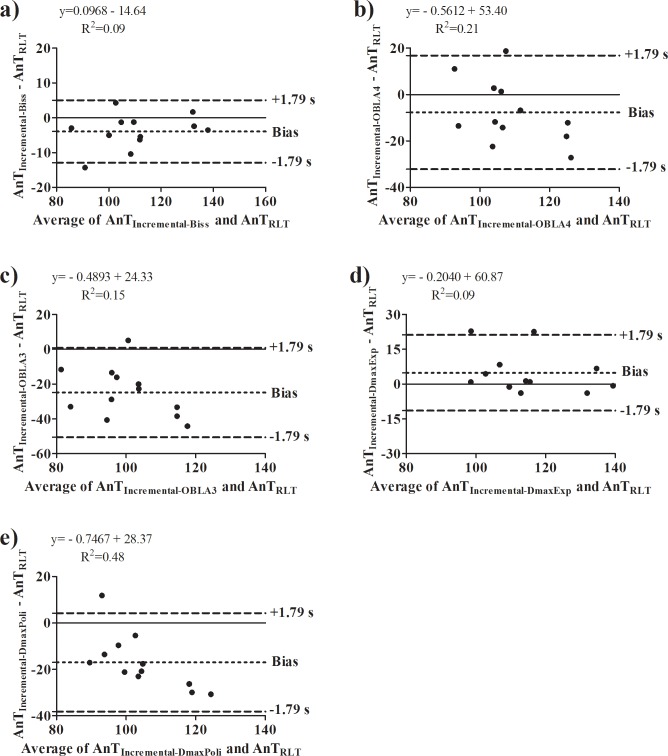
Bland-Altman analysis performed for anaerobic threshold intensity determined on the reverse lactate threshold test and incremental protocol on non-experienced individuals.a) Agreement between anaerobic threshold intensity determined on incremental protocol by the bissegmentation method (AnTInc-Biss) and reverse lactate threshold test (AnTRLT); b) Agreement between anaerobic threshold intensity determined on incremental protocol by fixed blood lactate concentration at 4 mmol.L-1 (AnTOBLA4) and AnTRLT; c) Agreement between anaerobic threshold intensity determined on incremental protocol by fixed blood lactate concentration at 3 mmol.L-1 (AnTOBLA3) and AnTRLT; d) Agreement between anaerobic threshold intensity determined on incremental protocol by maximal deviation method using the exponential adjustment (AnTDmaxExp) and AnTRLT; e) Agreement between anaerobic threshold intensity determined on incremental protocol by maximal deviation method using the second order polynomial adjustment (AnTDmaxPoli) and AnTRLT.